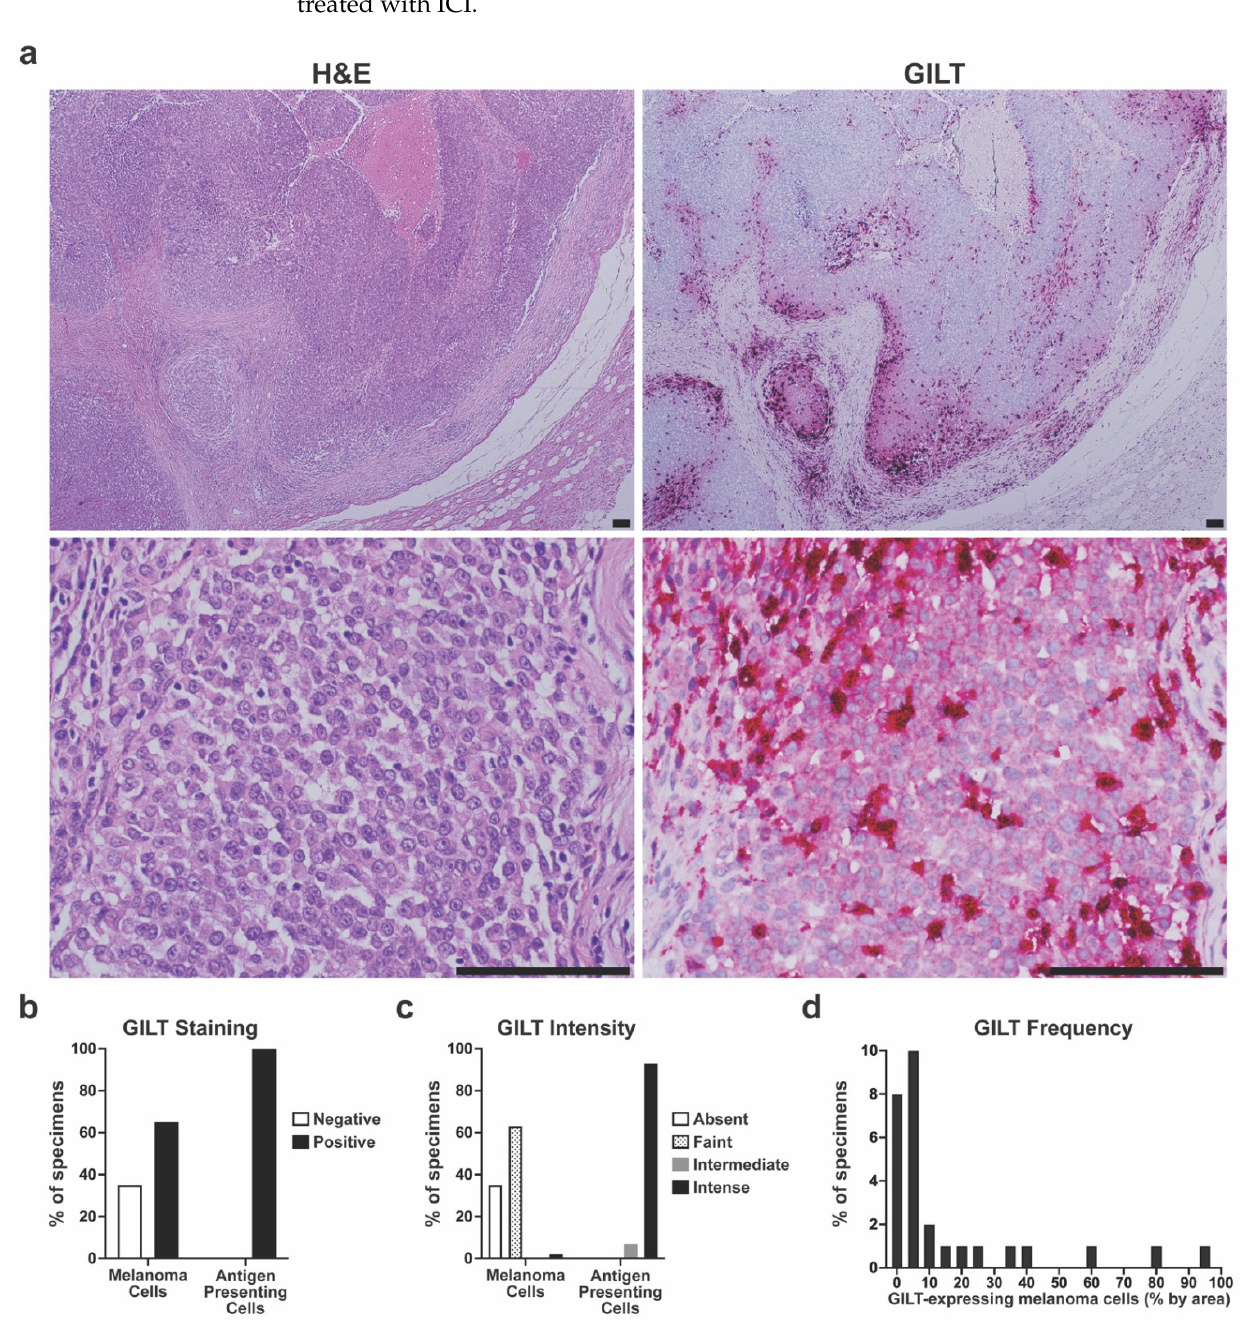
Figure 2. Variable GILT protein expression in melanoma cells of metastatic tumor specimens. ( a ) Representative hematoxylin and eosin (H&E) staining (left panels) and GILT immunohistochemical (IHC) staining of serial sections of metastatic melanoma specimens. Lower magnification (top panels) illustrates GILT staining in a subset of melanoma cells. Higher magnification (bottom panels) illustrates faint GILT staining within melanoma cells and intense GILT staining within antigen presenting cells with a dendritic morphology. Bar = 100 µm. ( b ) Percentage of metastatic melanoma specimens with negative or positive GILT staining in melanoma cells and antigen presenting cells. ( c ) Intensity of GILT staining within melanoma cells and antigen presenting cells in metastatic melanoma specimens. ( d ) Distribution of GILT-expressing melanoma cells within the n = 28 specimens with positive GILT staining in melanoma cells.